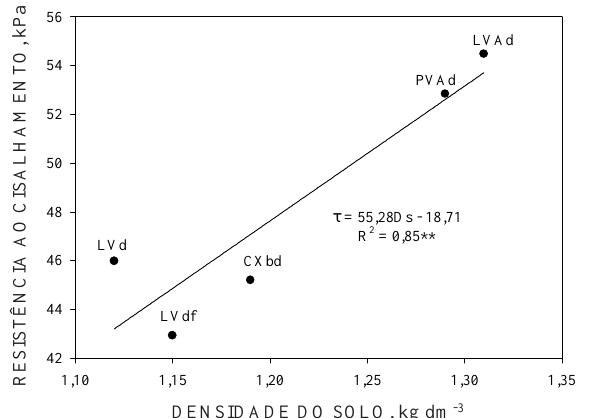
Figura 3. Variação da resistência ao cisalhamento dos solos com a densidade do solo.